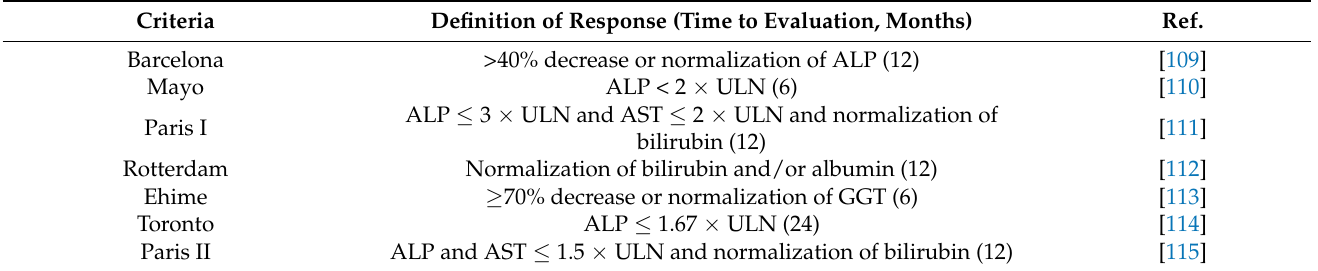
Table 1. Response criteria of UDCA therapy in patients with